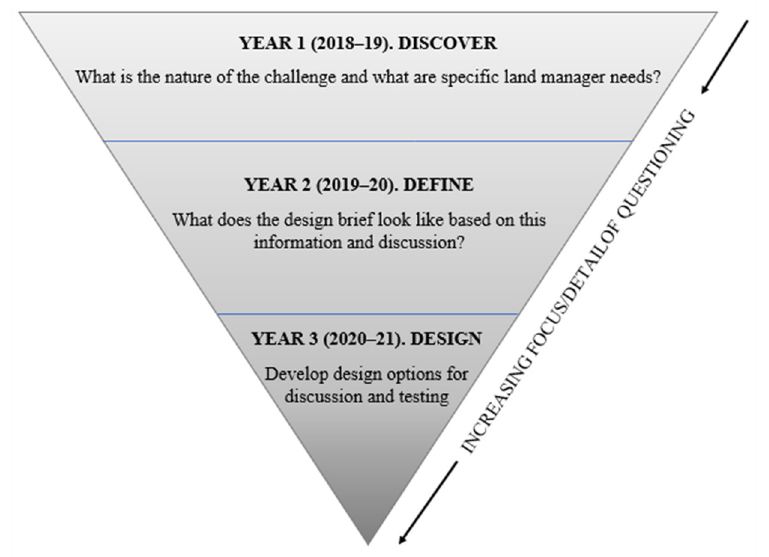
Figure 3. Different stages in evidence collection during the Tree Health Pilot policy co-design pro-